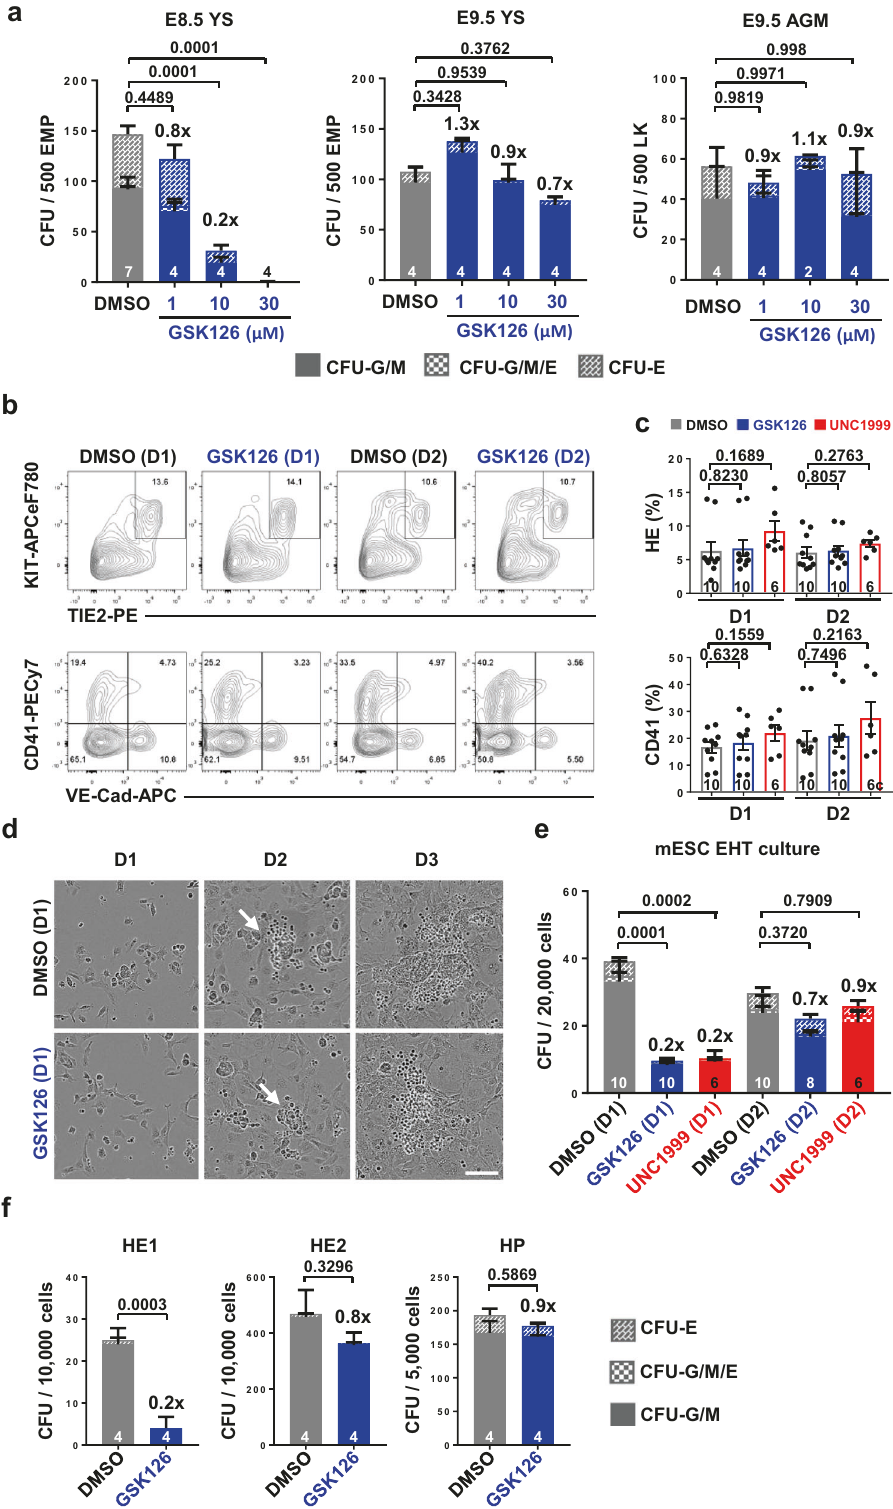
and HE2 (TIE2 + KIT + CD41 + ) based on the acquisition of CD41 hematopoietic colonies (Fig. 3e). Importantly, delaying the Ezh2 inhibition from day 1 to day 2 of culture dramatically reduced this expression 8 . HE2 subsequently differentiates into HP (TIE2 - KIT + CD41 + ) by losing TIE2 expression. We speci fi cally inhibited Ezh2 impact, indicating a more prominent role of Ezh2 early in the EHT. Co-inhibition of Ezh1 (UNC1999) did not exacerbate the effect in sorted HE1, HE2, and HP populations (Supplementary Fig. 7d). (Fig. 3e). EHT is a highly dynamic non-synchronous process in bulk Ezh2 inhibition exhibited the most signi fi cant impact on the cultures. HE can be further separated into HE1 (TIE2 + KIT + CD41 lo ) hematopoietic colony outputs of these cultures when added at the NATURE COMMUNICATIONS| (2021) 12:7019